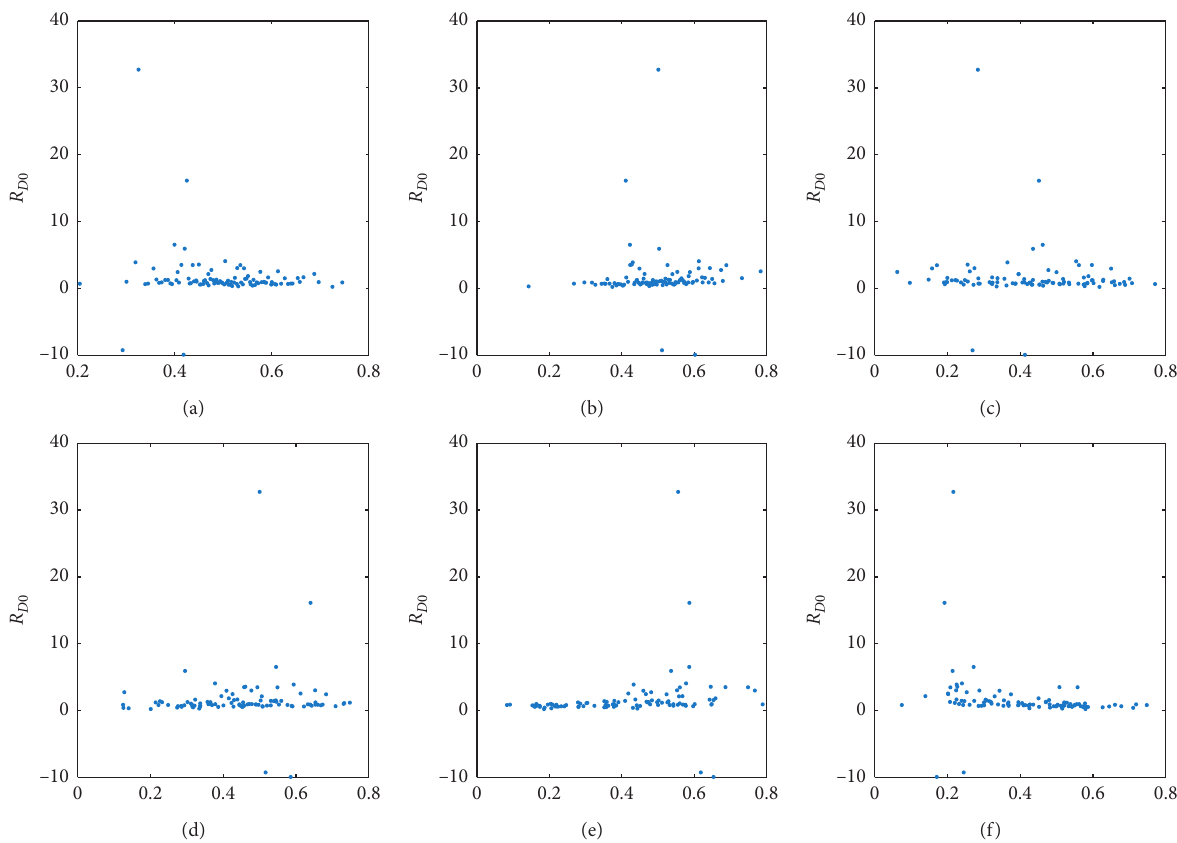
Figure 8: Scatter plots for the basic reproduction number R D 0 and six sampled input parameters’ values. These results have been obtained from Latin hypercube sampling using a sample size of 100. (a) β 1 . (b) β 2 . (c) α 1 . (d) α 2 . (e) c 1 . (f) c 2